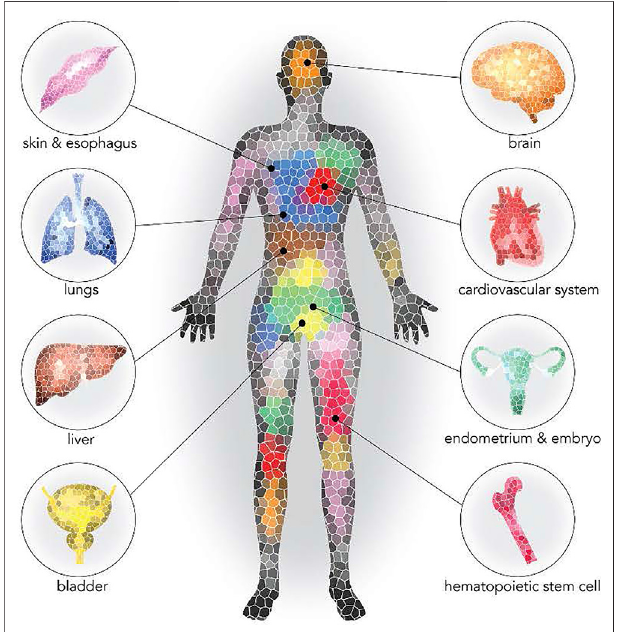
FIGURE1| Prevalenceofclonalexpansioninnormaltissues(Sanoetal., 2020). Reprinted with